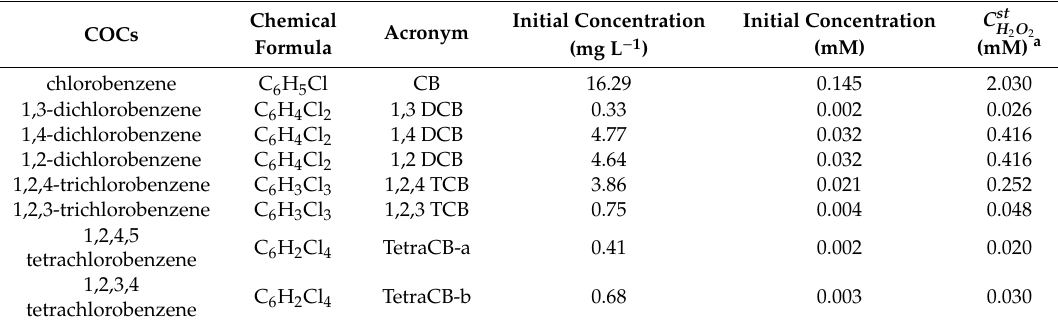
Table 2. Initial concentration of chlorobenzene compounds (nCBs) in the spiked